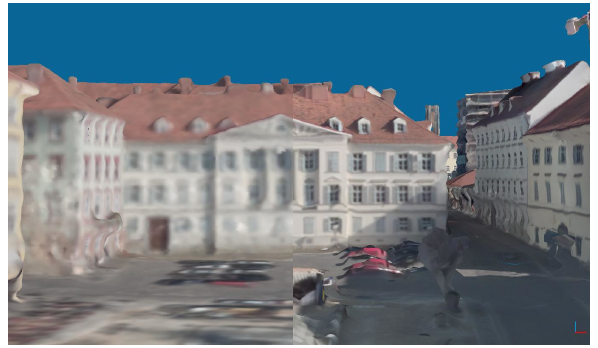
Figure 5. Comparison of the cleaned (but untextured) 3D geometry on the left with the raw, textured 3D reconstruction on the right. Cars, trees, and elements of street infrastructure (class clutter ), visible on the right, are missing on the left side.